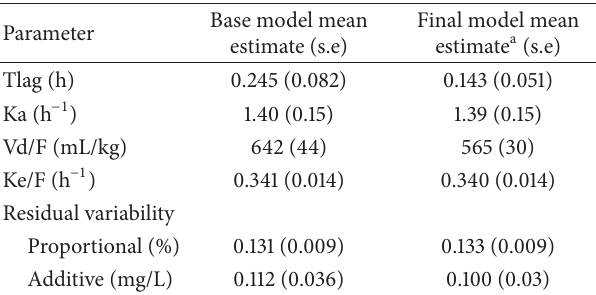
Table 3: Parameter estimates of the base and the final population pharmacokinetic model for